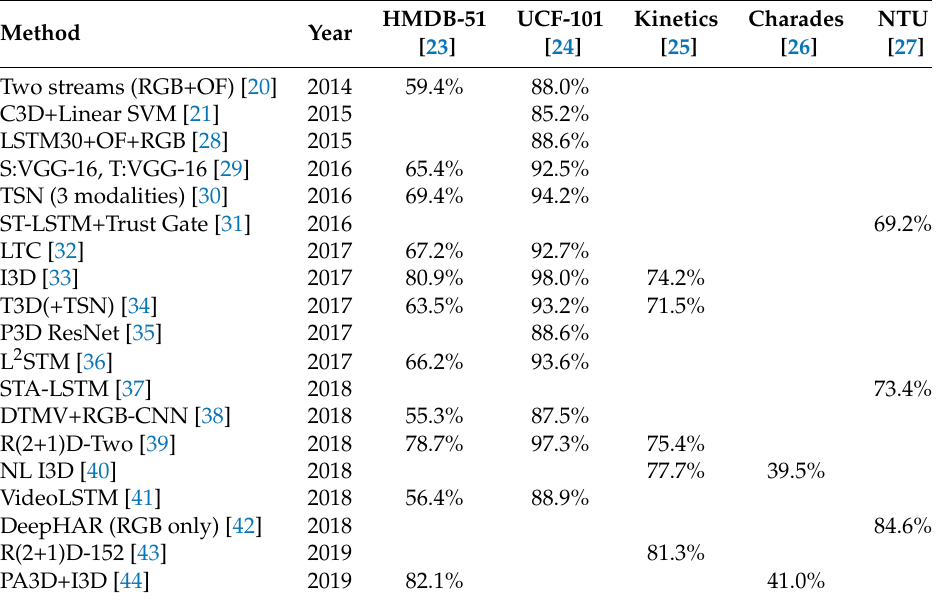
Table 1. List of major action recognition methods and their performance on used